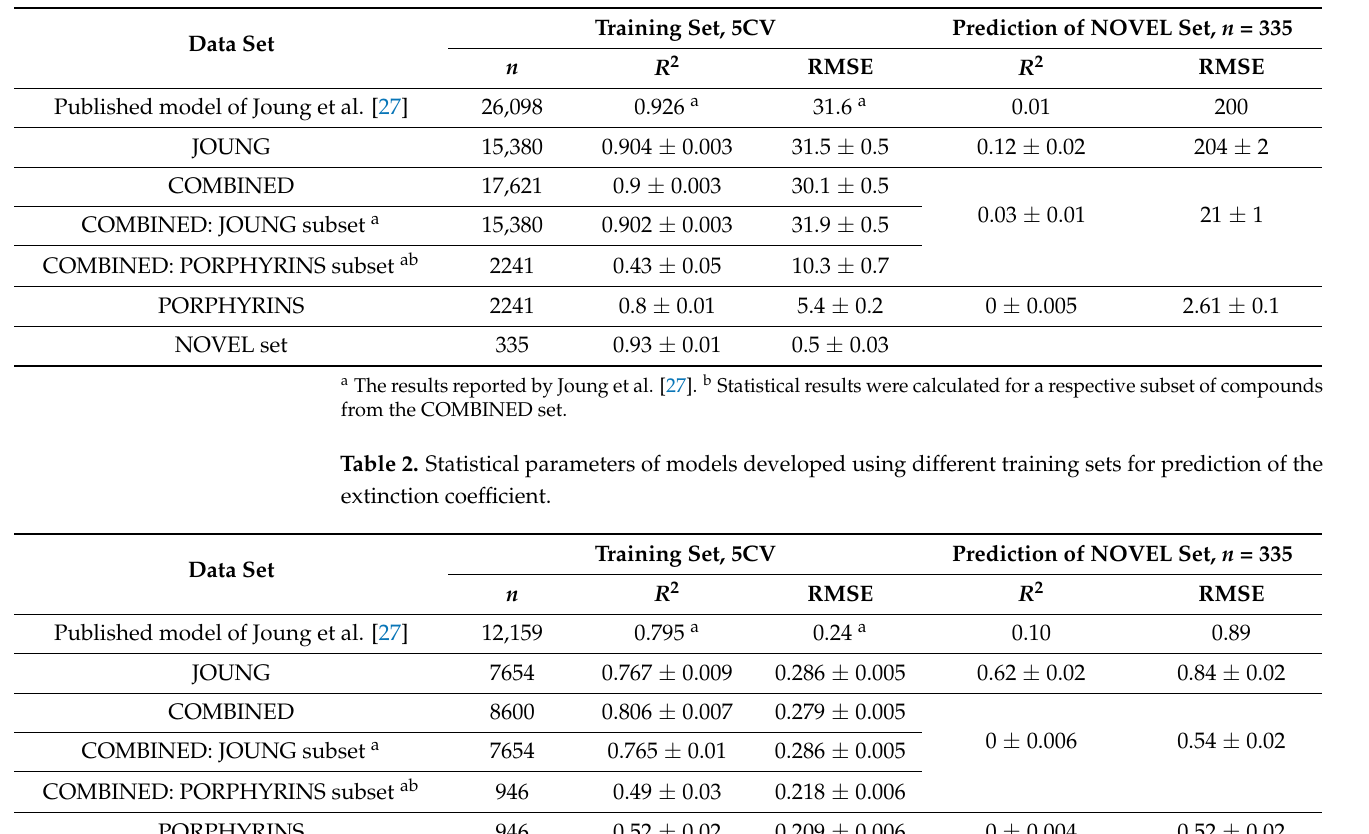
Table 1. Statistical parameters of models developed using different training sets for prediction of absorption maximum band.